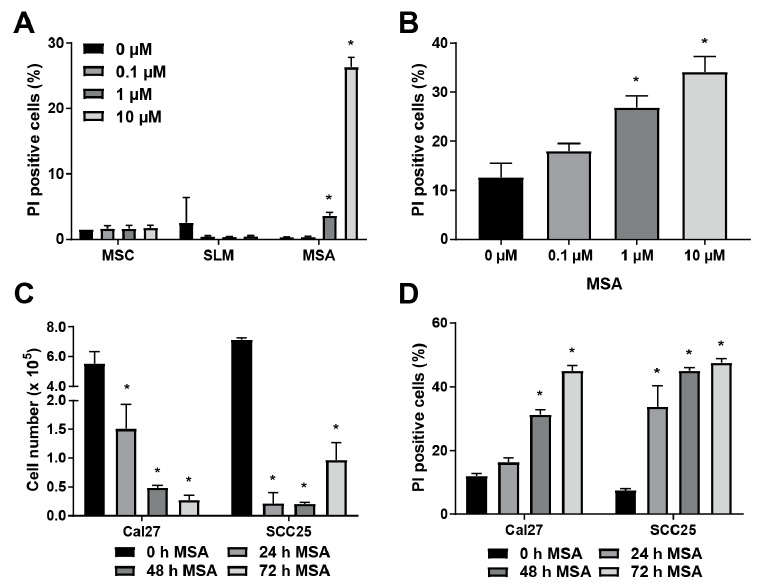
Figure 1. Methylseleninic acid (MSA) is toxic to Cal27 and SCC25 HNSCC cells in a dose- and time-dependent manner. ( A ) PI exclusion assay of Cal27 cells treated with the shown concentrations of Se-methylselenocysteine (MSC), seleno- L -methionine (SLM), or MSA for 72 h. ( B ) Propidium iodide (PI) exclusion assay of SCC25 cells treated with 0 to 10 µ M MSA for 72 h. ( C ) Cell counts of Cal27 and SCC25 cells following treatment with 10 µ M MSA for 0 to 72 h. ( D ) PI exclusion assay of Cal27 and SCC25 cells after treatment with 10 µ M MSA for 0 to 72 h. *, statistical significance relative to 0 µ M MSA controls; p < 0.05, n =